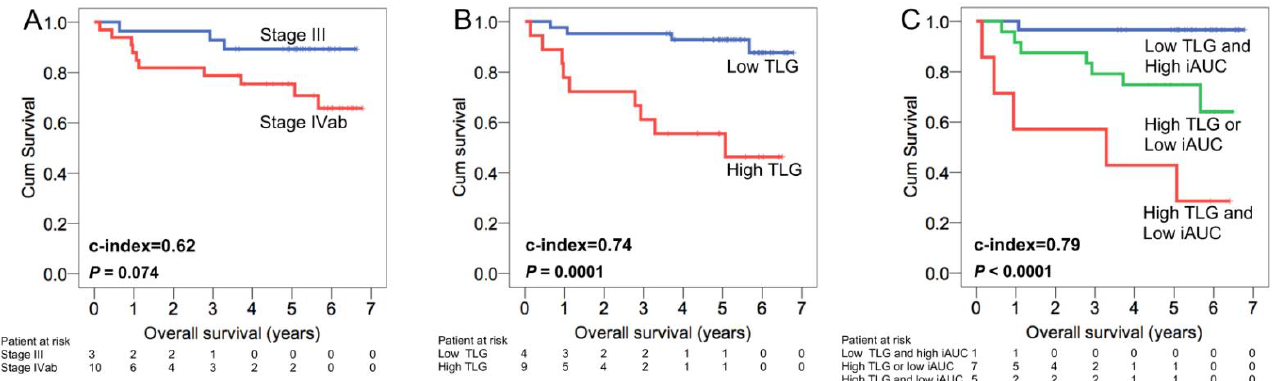
Figure 2. Comparison of patient overall survival stratified based on the TNM stage ( A ), PET biomarker, TLG ( B ), and the prognostic model incorporating both PET and MRI biomarkers, the TLG and iAUC ( C ). This combined model enabled a better survival stratification with a higher c-index compared with that of TLG alone. It also exhibited a significantly higher c-index than that of the TNM system. TLG, total lesion glycolysis; iAUC, initial area under the curve.